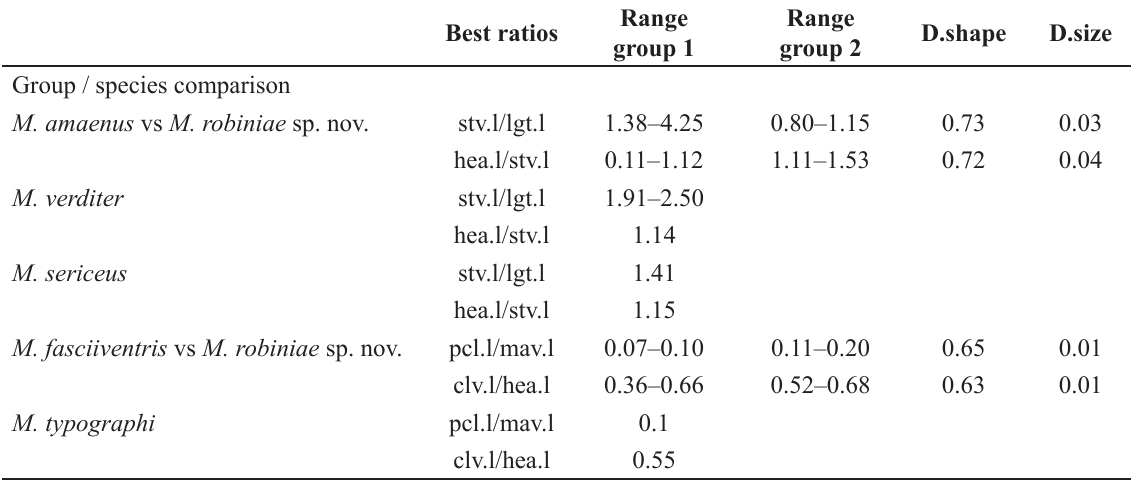
Table 3. First and second-best ratios found by the LDA ratio extractor for separating various groups and specimens of Mesopolobus Westwood, 1833 females.